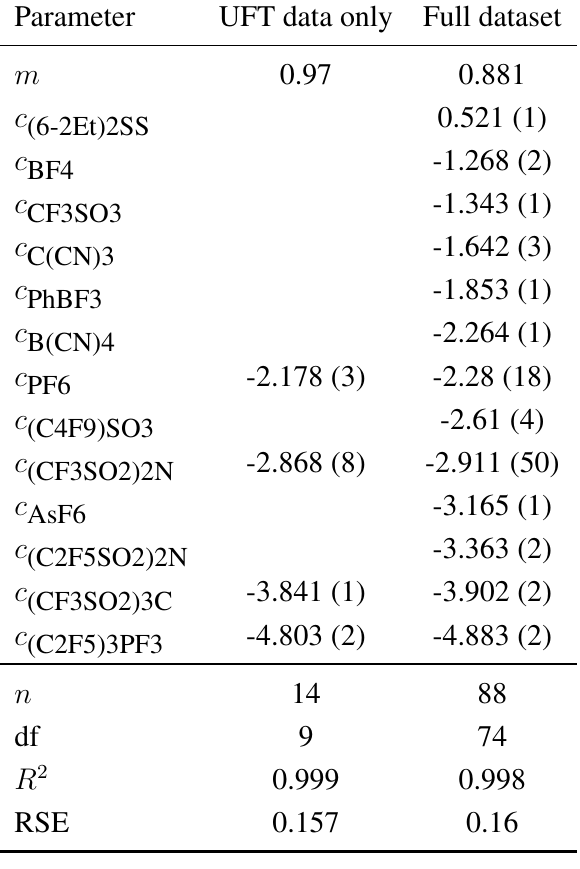
Table 4. Statistical parameters of the model described in equation 1 applied to only our own water solubility data at 293.15 K (UFT data only), and the complete water solubility dataset for 293.15 ± 5 K (Full dataset) given in Table 3. Numbers in parentheses after the anion constants are the number of data points for each anion that the constant is based on. n is the overall number of data points in the model, df is the number of statistical degrees of freedom, R 2 is the fraction of the variability in water solubility explained by the model, and RSE is the standard error of the residuals. Note that data points for anions that are only present in one IL have a zero residual, giving a favorable bias to R 2 and RSE. The anion acronym (6-2Et)2SS stands for